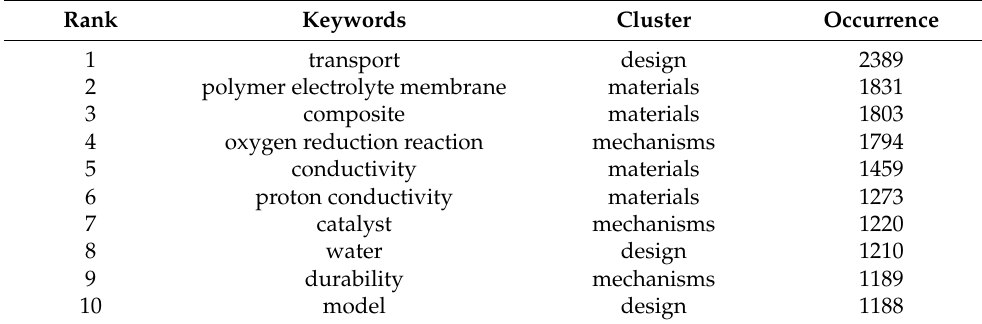
Table 6. Information summary of the top 10